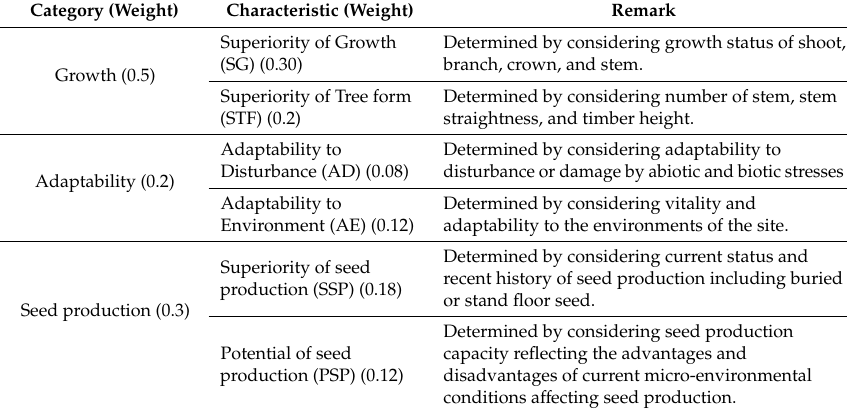
Table 2. Selection criteria and weights of characteristics used for candidate tree selection in Quercus salicina and Q.